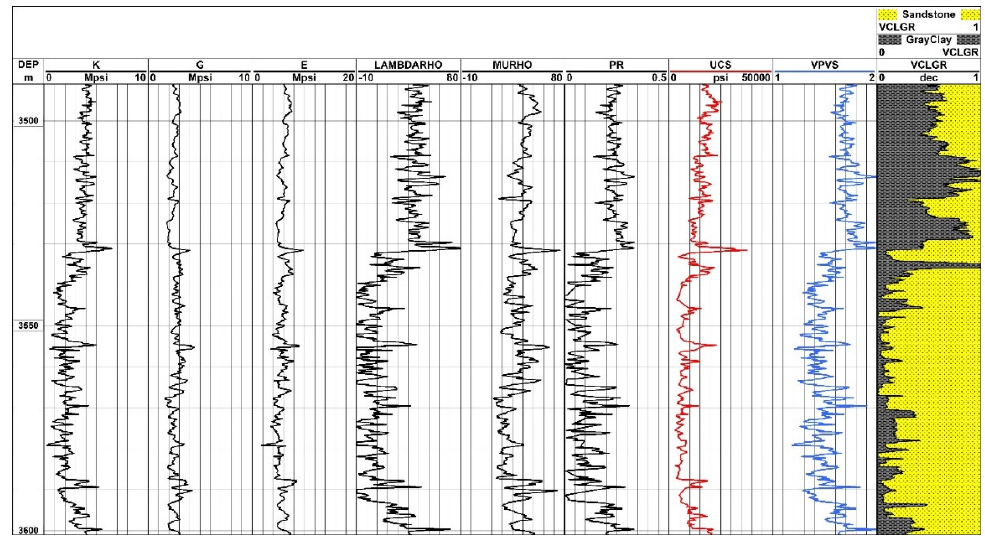
Figure 6. Mechanical rock parameters calculated for available depth interval in Rehmat-02 well. The lithology is also displayed in the colored column next to each plot.